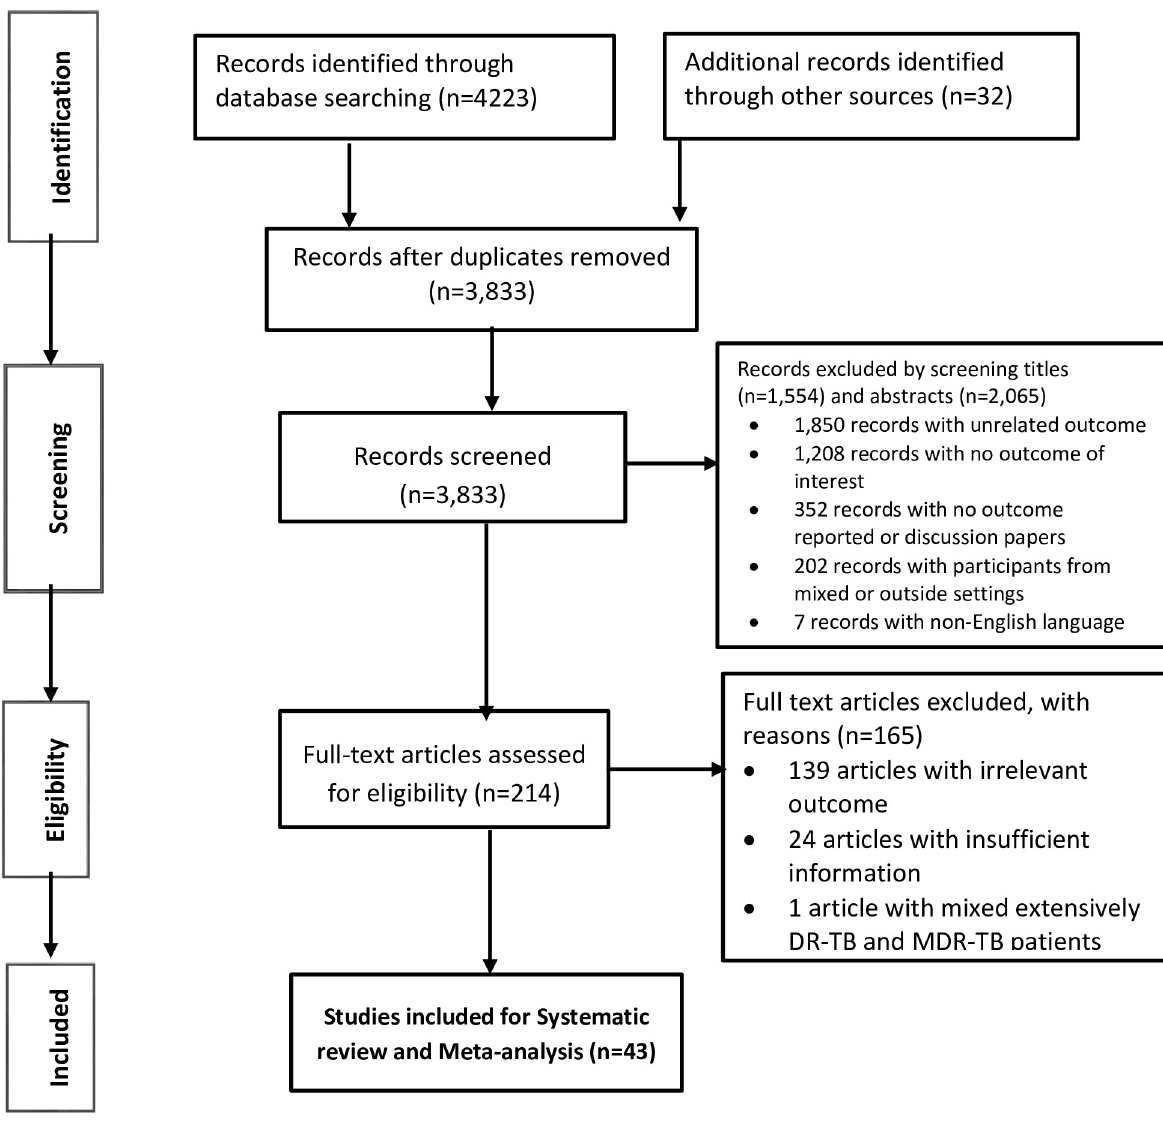
Fig 1. PRISMA flow diagram depicting the selection